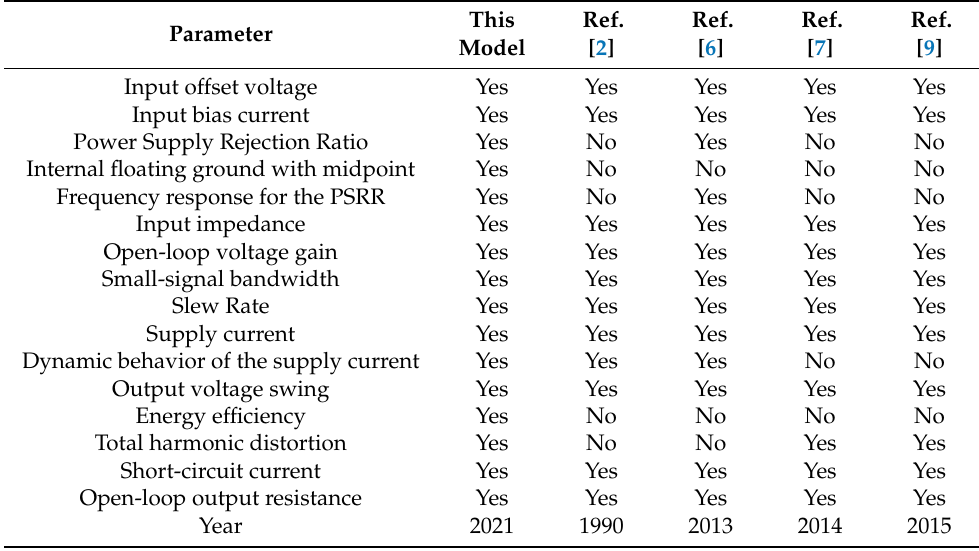
Table 3. Comparison with other simulation